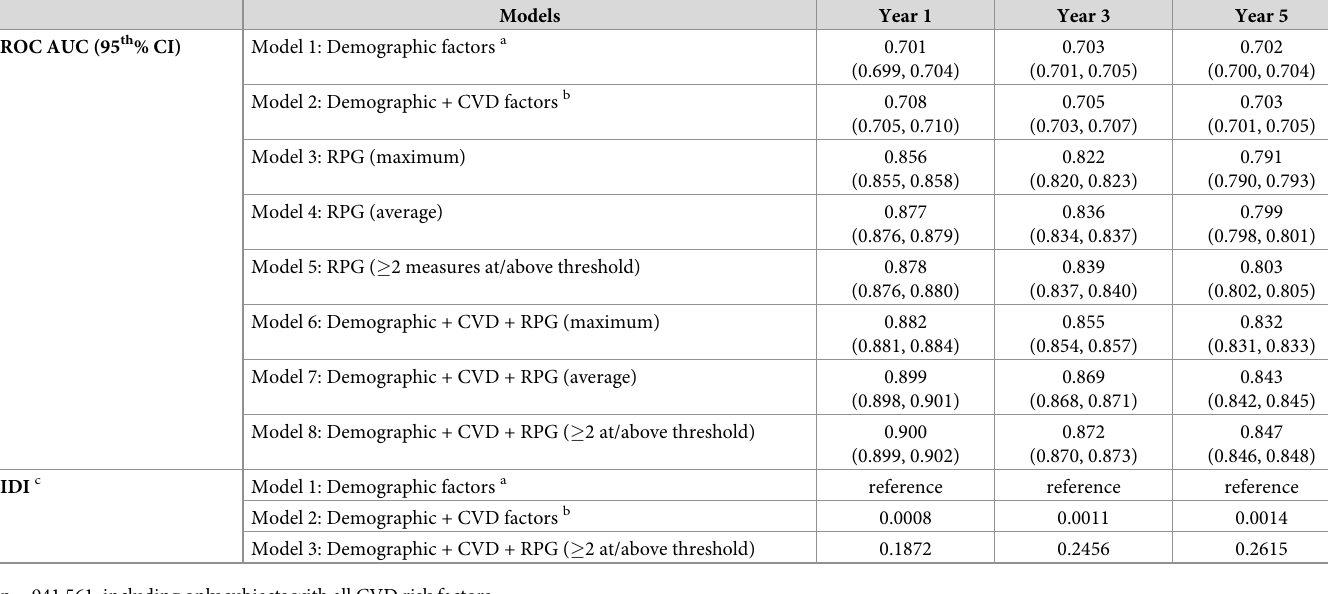
Table 2. ROCs and integrated discrimination improvement (IDI) for prediction of diabetes at years 1, 3, and